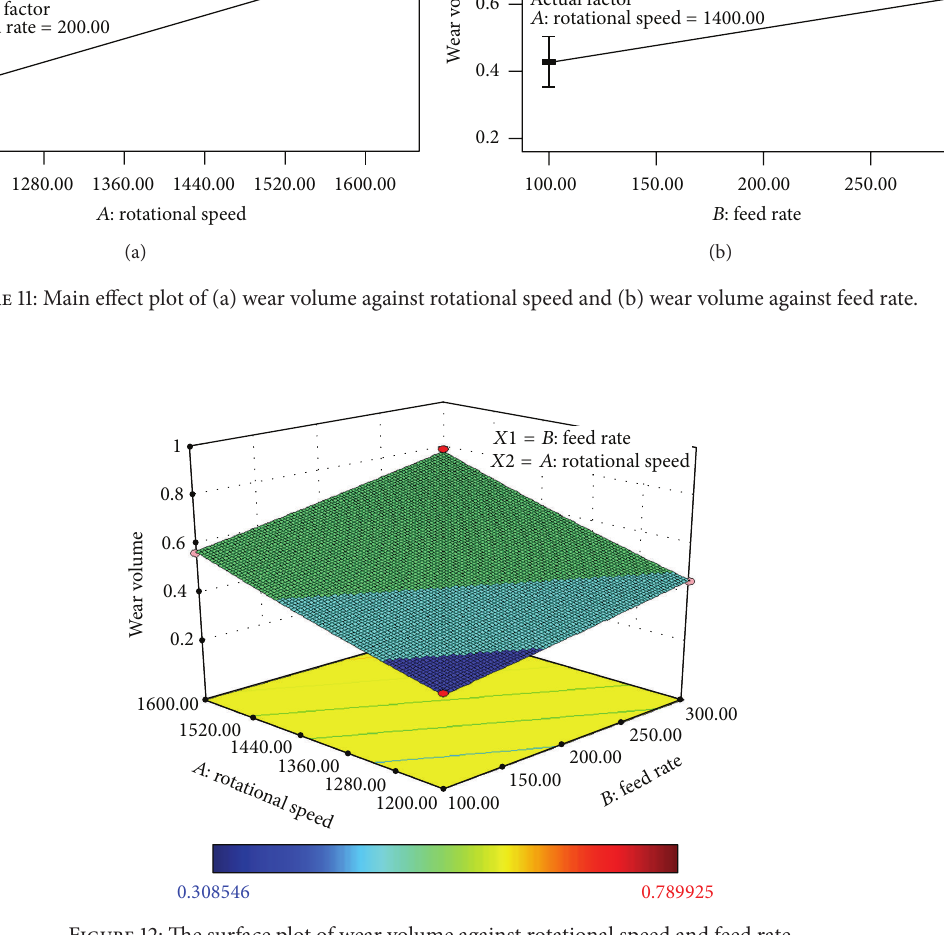
Figure 12: The surface plot of wear volume against rotational speed and feed rate.